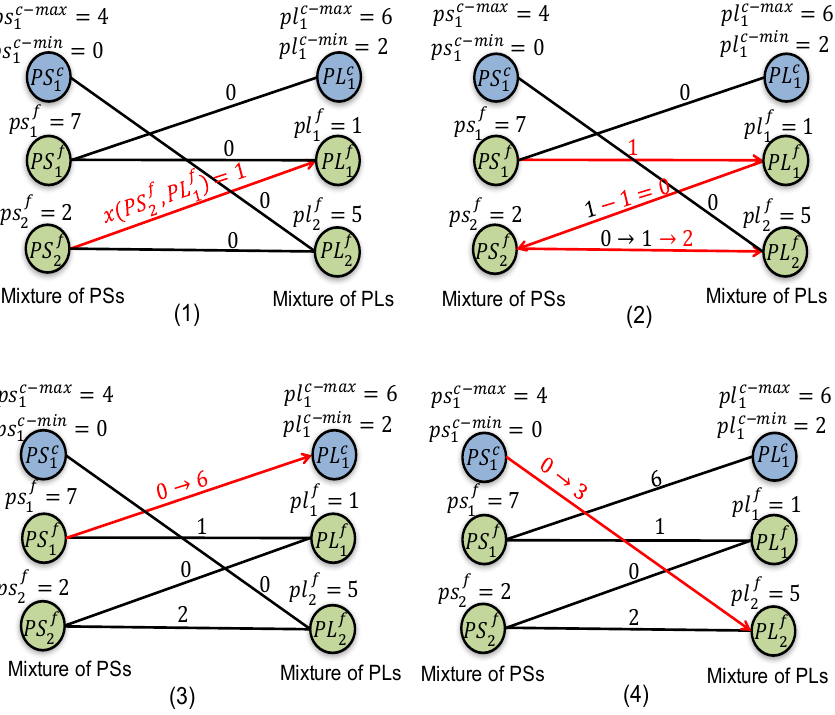
Figure 12. Demonstration example for feasible solution case.